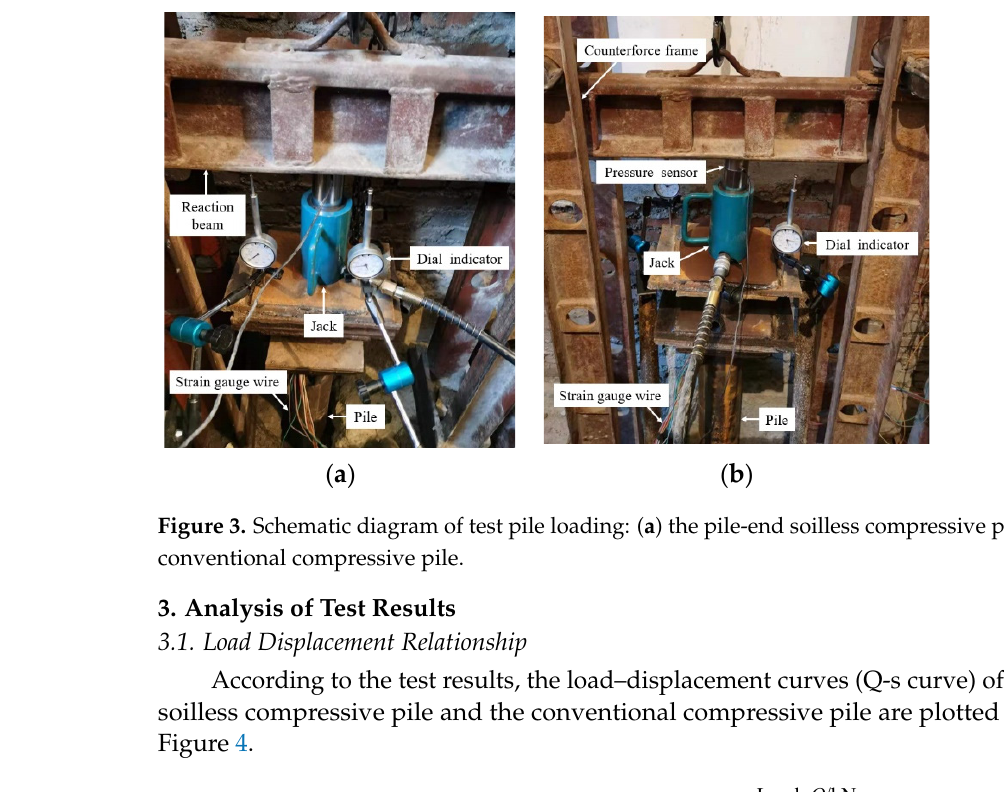
Figure 2. Schematic diagram of the pile-end soilless compressive pile.